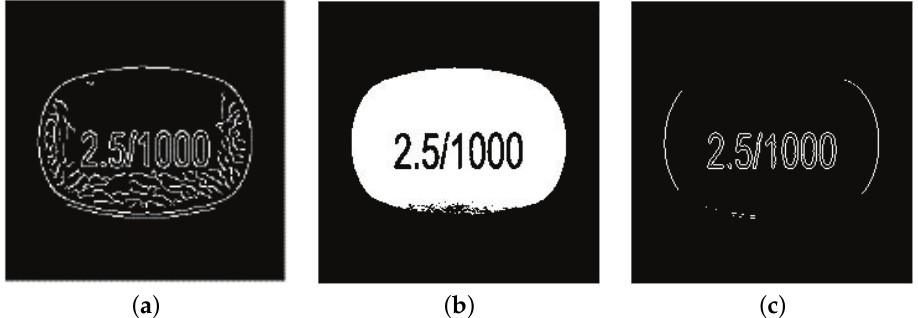
Figure 5. Pill image imprint extraction process: ( a ) Canny edge detector. ( b ) Dilution. ( c ) Scale Invariant Feature Transform.